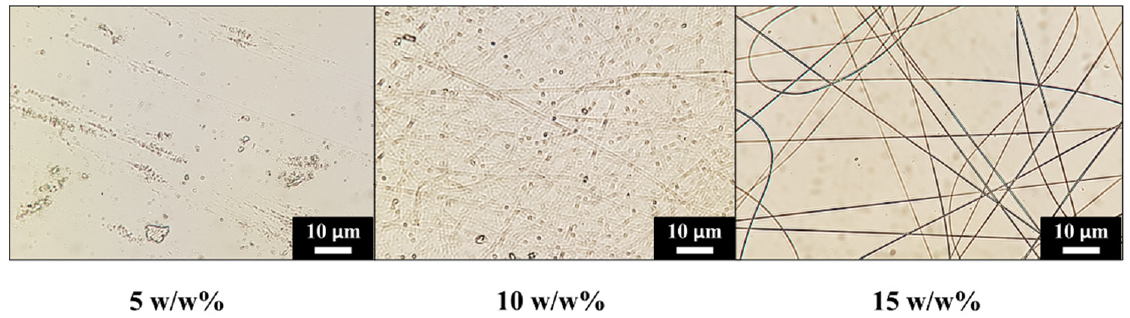
Figure 5. Fibre formation confirmation with light microscopy.